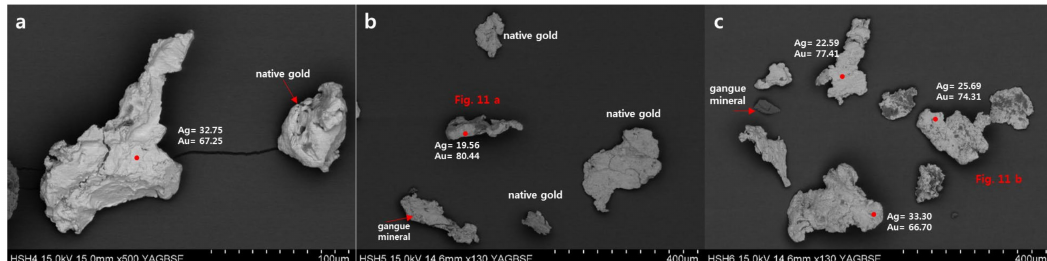
Figure 9. XRD patterns of the heavy fraction from insoluble residue by hydro-separation. A: adularia; Ch: chalcopyrite; F: fluorspar; G: gold; M: magnetite; P: pyrite; Q: quartz.